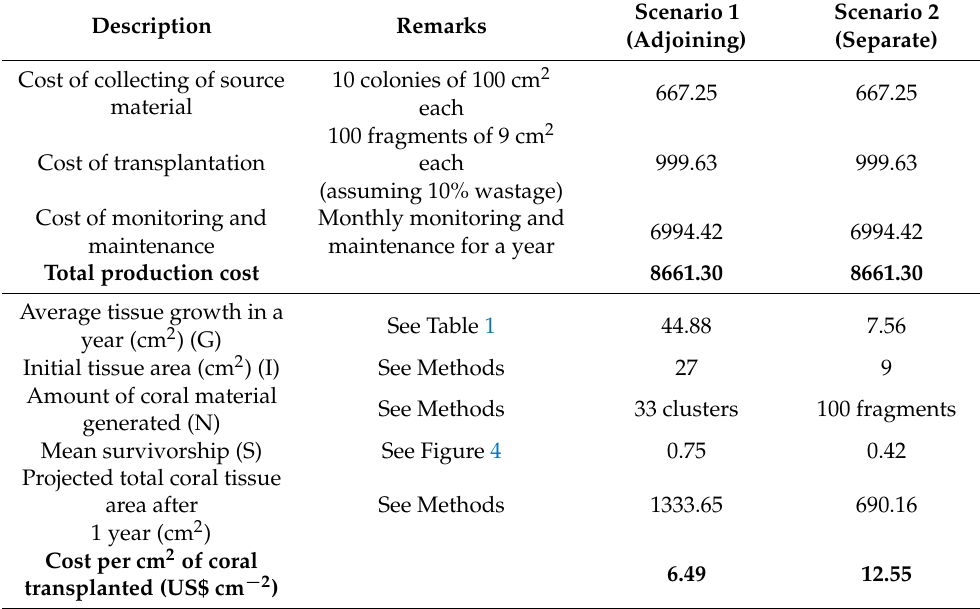
Table 2. Cost estimates (in USD) of transplanting coral fragments adjoining to promote nonfusion (Scenario 1, “adjoining”) versus transplanting fragments apart (Scenario 2,